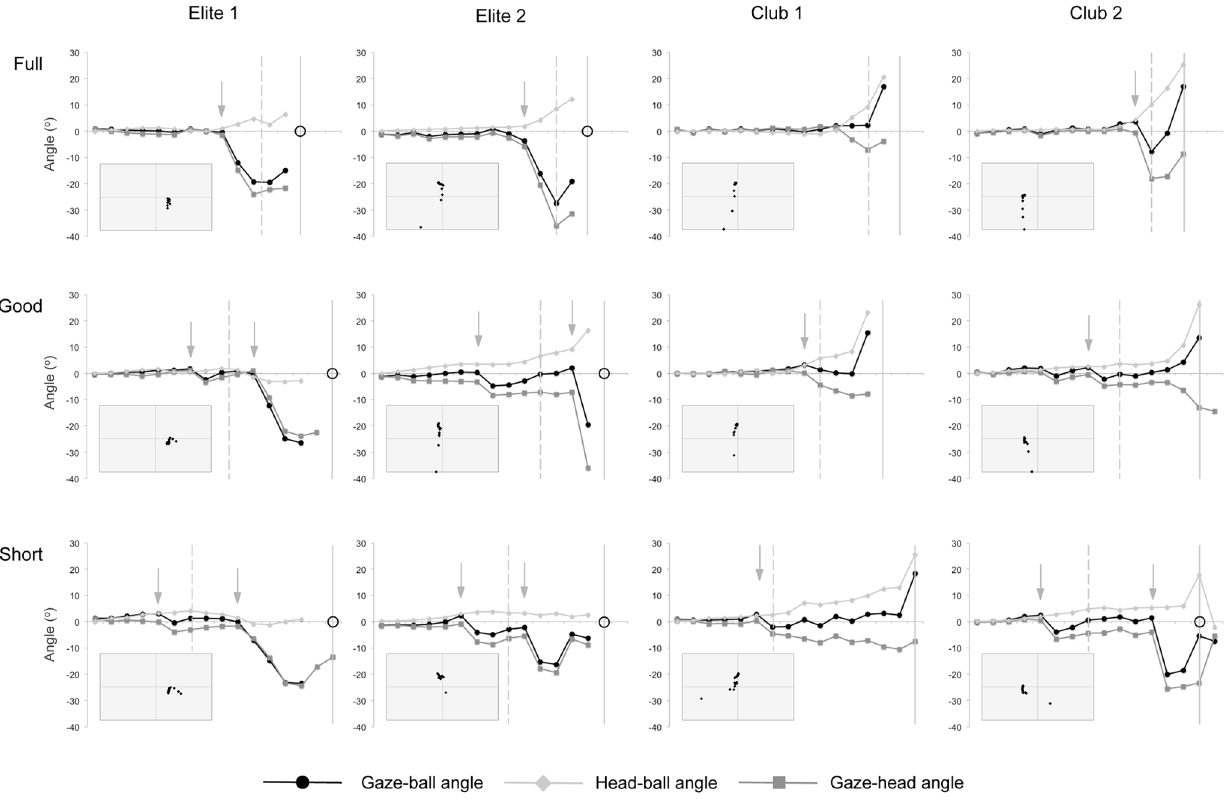
Figure 4. Exemplar trials for each batsman. Demonstration of gaze-ball, gaze-head, and head-ball angles in an exemplar trial for each location of ball-bounce for all four participants. Vertical arrows indicate predictive saccades. Broken vertical lines indicate the timing of ball bounce and solid vertical lines indicate the timing of bat-ball contact. Open circles highlight that an experimenter viewing Mobile Eye footage of the trial judged gaze to have coincided with the ball at the moment it was hit (see Method). Rectangular insets show the location (in x-y coordinates for each video frame) of the ball relative to the direction of the batter’s head (see Method).